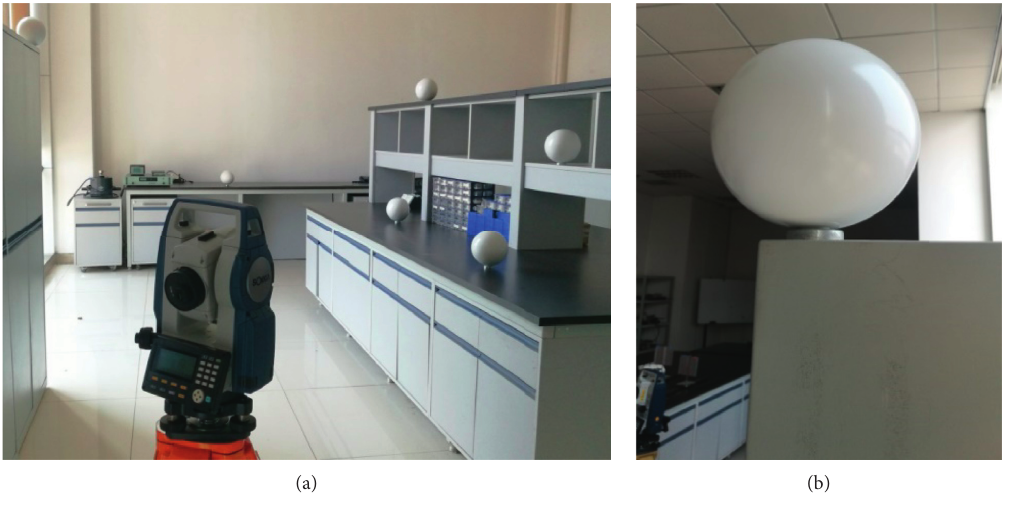
Figure 7: Scanning the test target sphere using the total Table 5: The difference between real and transformed coordinates.